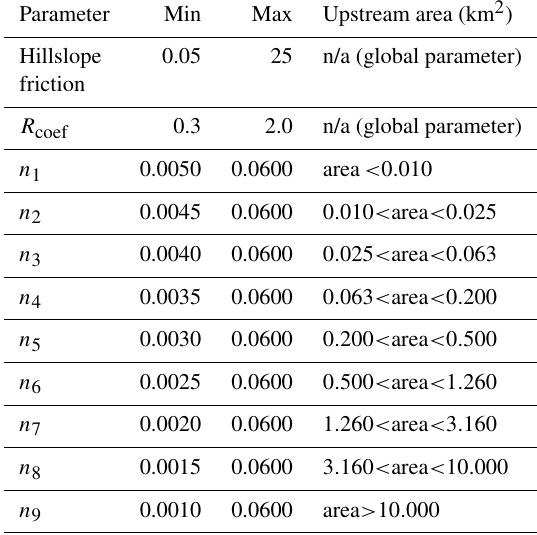
Table 1. Field-based constraints on HRR routing model parameters (from the literature and Gleason et al.,